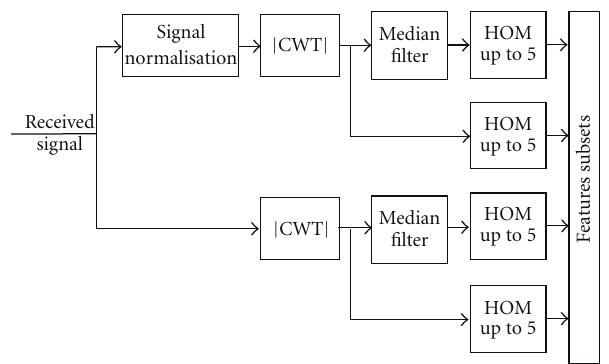
Figure 6: The processing chain of di ff erent features subsets extraction.